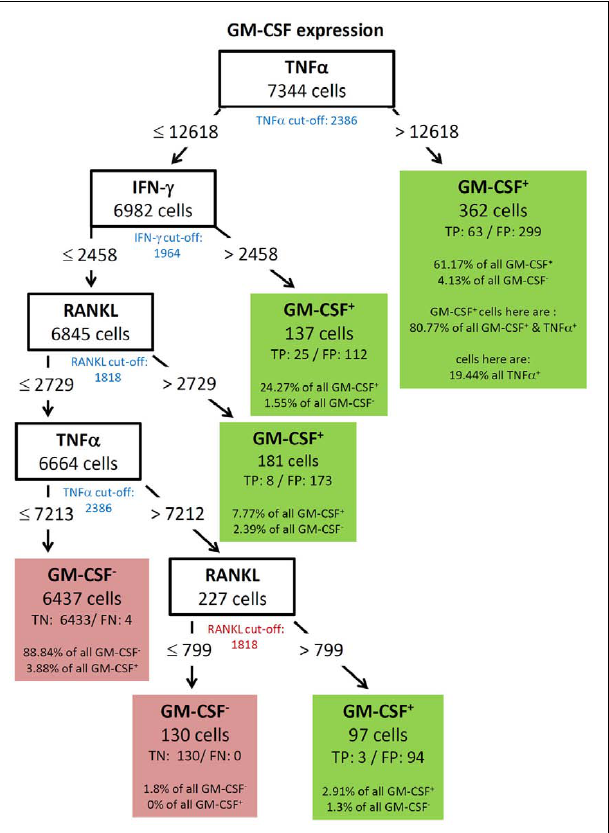
FIGURE 8 | Best decision tree for the classification of cells as positive or negative for GM-CSF expression. Cells are first classified based on the MFI values ofTNF- α .The blue coloredTNF- α cut-off value indicates that the split value is high above the cut-off value.Therefore, only a proportion of the cells which expressTNF- α are routed to the right leaf. A closer look at this leafs shows that due to the split value high above the cut-off value only 19.44% of allTNF- α positive cells are contained in this leaf. But this leaf captures 61.17% of the GM-CSF positive cells.The leaf also contains the information that this leave captures 80.77% of all GM-CSF andTNF- α positive cells. Form the root (top) cells with aTNF- α MFI value equal or below 12618 are routed down to the next inner node.This node splits the cells on the MFI value of IFN- γ . Again, the blue colored cut-off values indicates that not all IFN- γ positive cells in this node are routed to the leaf at the right.This leaf also classifies cells as GM-CSF positive.This leaf captures less of the GM-CSF positive cells – around one out of four.The other two leafs which give a positive classification captures even less of the GM-CSF positive cells, but summed up the four leaves which give a positive classification captures 96.12% of all GM-CSF positive